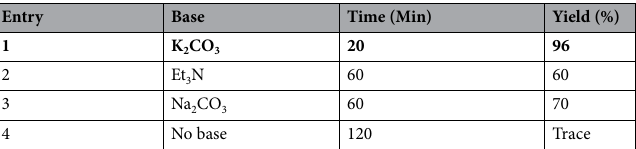
Table 4. Screening of base. Reaction conditions: 4-methylbromobenzene (1.0 mmol), phenylboronic acid (1.0 mmol), UiO-66-biguanidine/Pd, EtOH/H 2 O (1:1) as solvent (3 mL) at 50 °C; Isolated